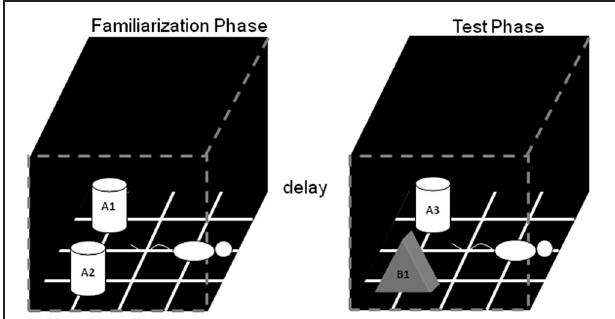
FIGURE 1 | Schematic of the standard SOR task. The white cylinders and the black pyramid indicate the location in which the objects were placed during both phases of recognition testing. The schematic white rat shows the orientation in which the rat was placed when it is first put into the arena. During the object familiarization phase (left box), a rat is placed in the arena and allowed to explore duplicate copies of an object (A1 and A2). After this object familiarization phase, the rat is moved out of the arena for a variable delay (2min, 15min, 2h, or 24h). Following the delay, during the test phase (right arena), the animal is returned to the arena to explore a triplicate copy of the object presented during the familiarization phase (A3) and a novel object (B1) (after Burke et al.,